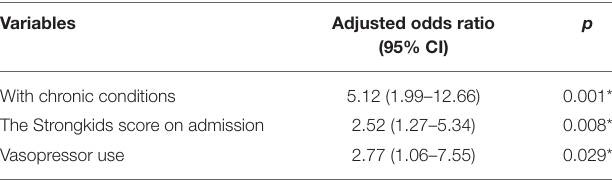
TABLE 4 | Risk factors of PICU early readmission in the multivariate analysis.